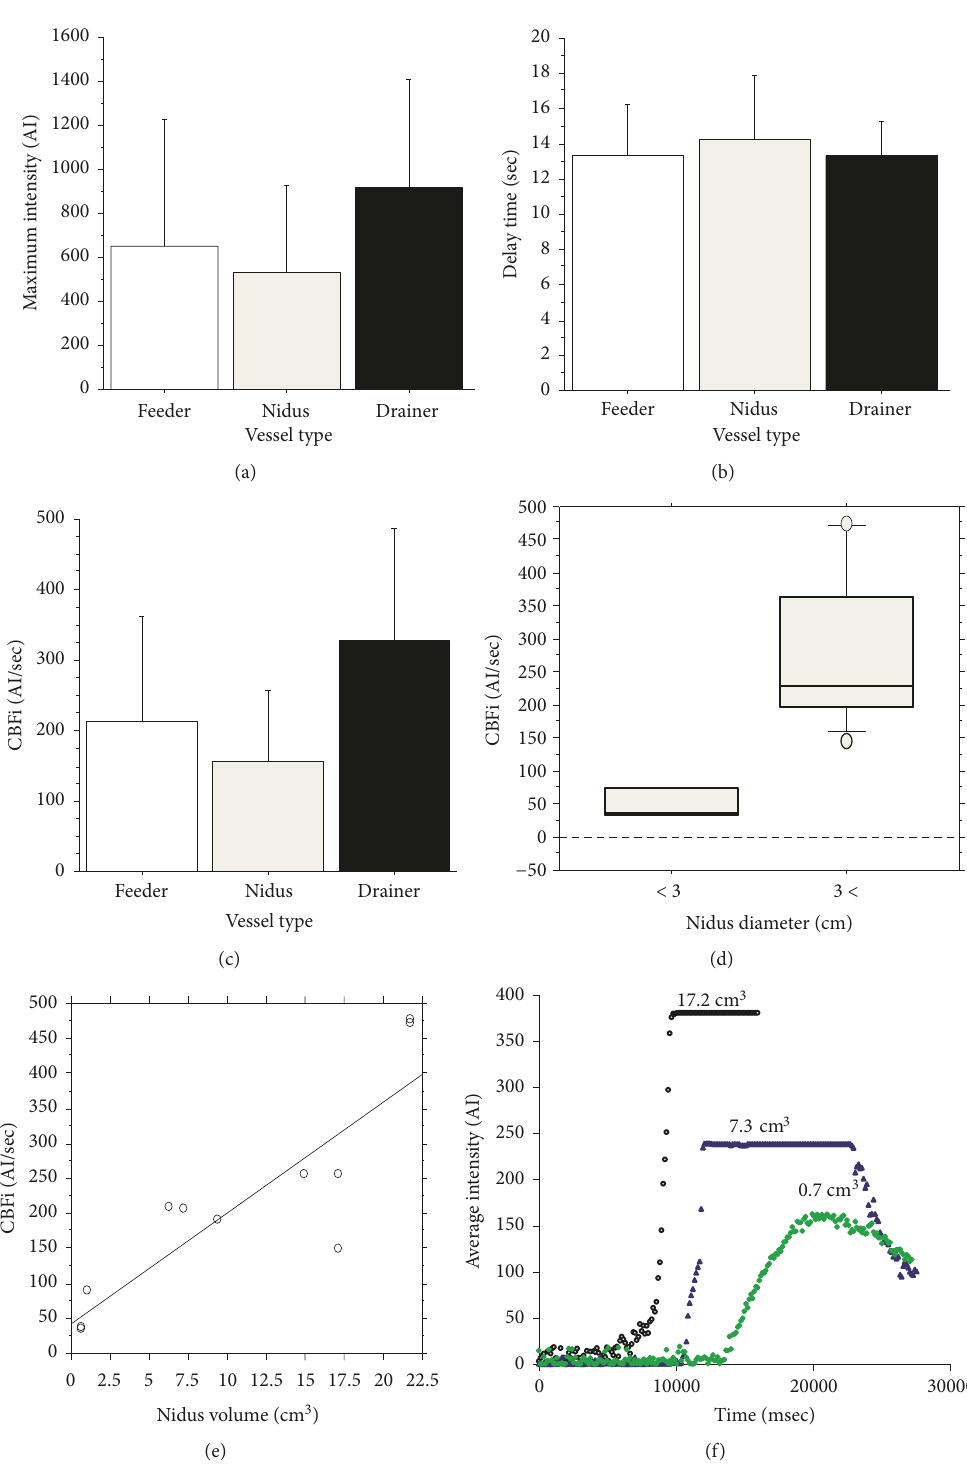
Figure 2: Comparison of parameters according to vessel types. Maximum intensity (a), delay time (b), and CBFi (c). Values showed absence of significant differences among the vessel types. The CBFi value of the feeders was significantly higher in the niduses of > 3-cm diameter (d). In addition, the CBFi of the feeders was correlated with the cubage of the nidus (e). Representative time-intensity diagrams presenting three different patterns according to the nidus volume (f). CBFi: cerebral blood flow